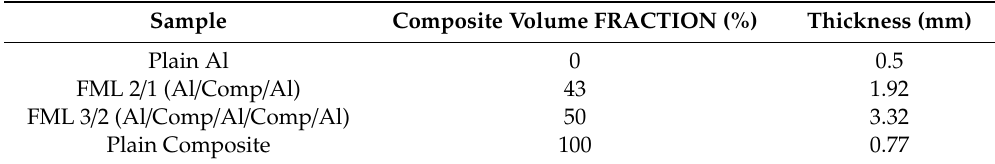
Figure 2. Investigated fiber metal laminates (FML) 3/2 system ( a ) Schematic representation ( b ) FML 3/2 side view. Table 1. Stacking configurations investigated in this study.